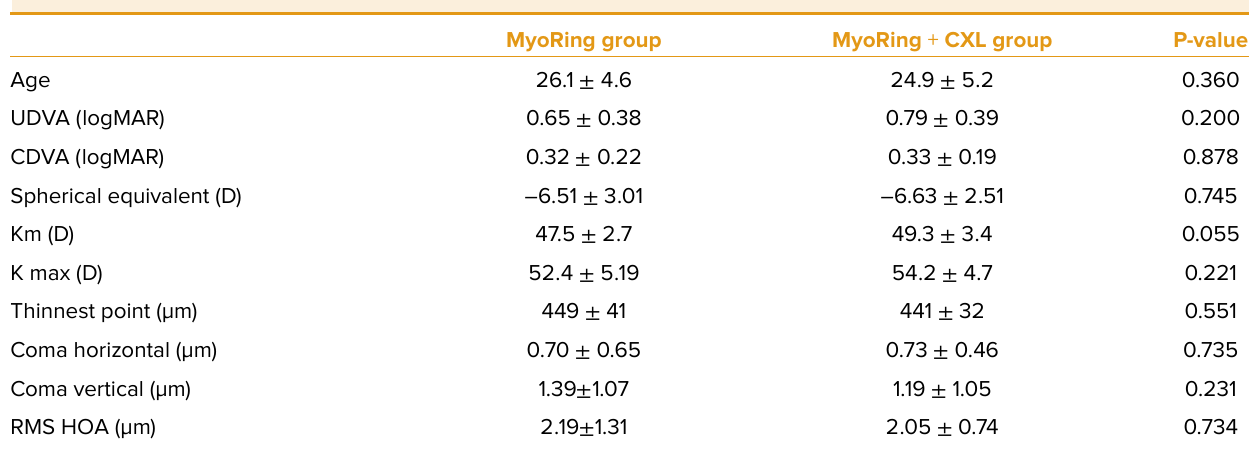
Table 1. Mean of the preoperative data